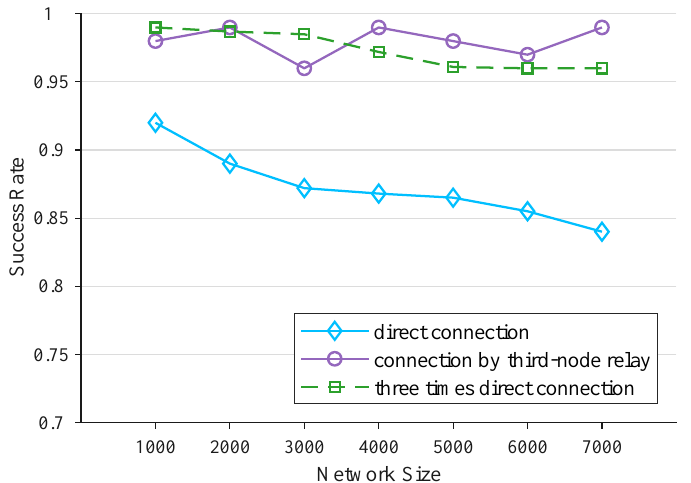
Figure 20. Success rates of two methods of establishing communication channels at different net- work